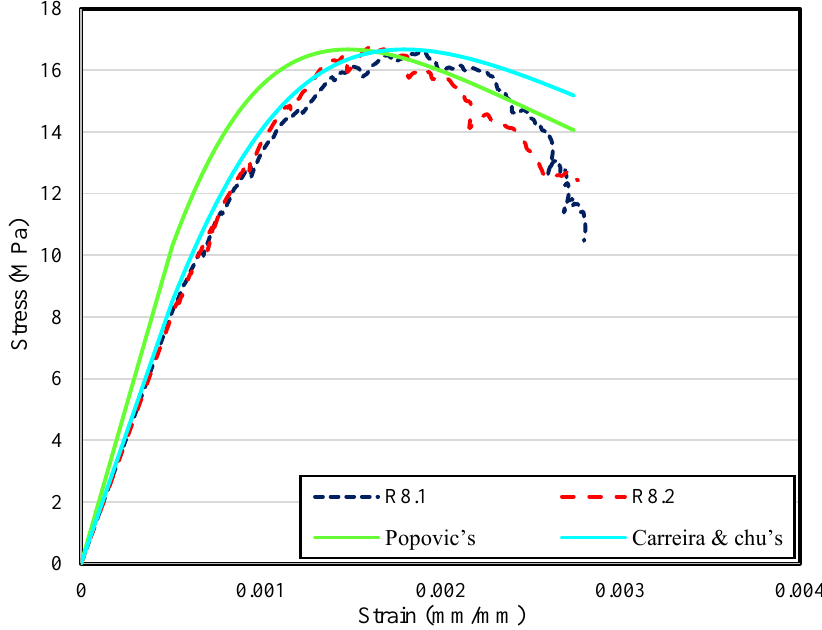
Figure 23. Comparison of stress-strain curves of R8 mix with existing constitutive models.